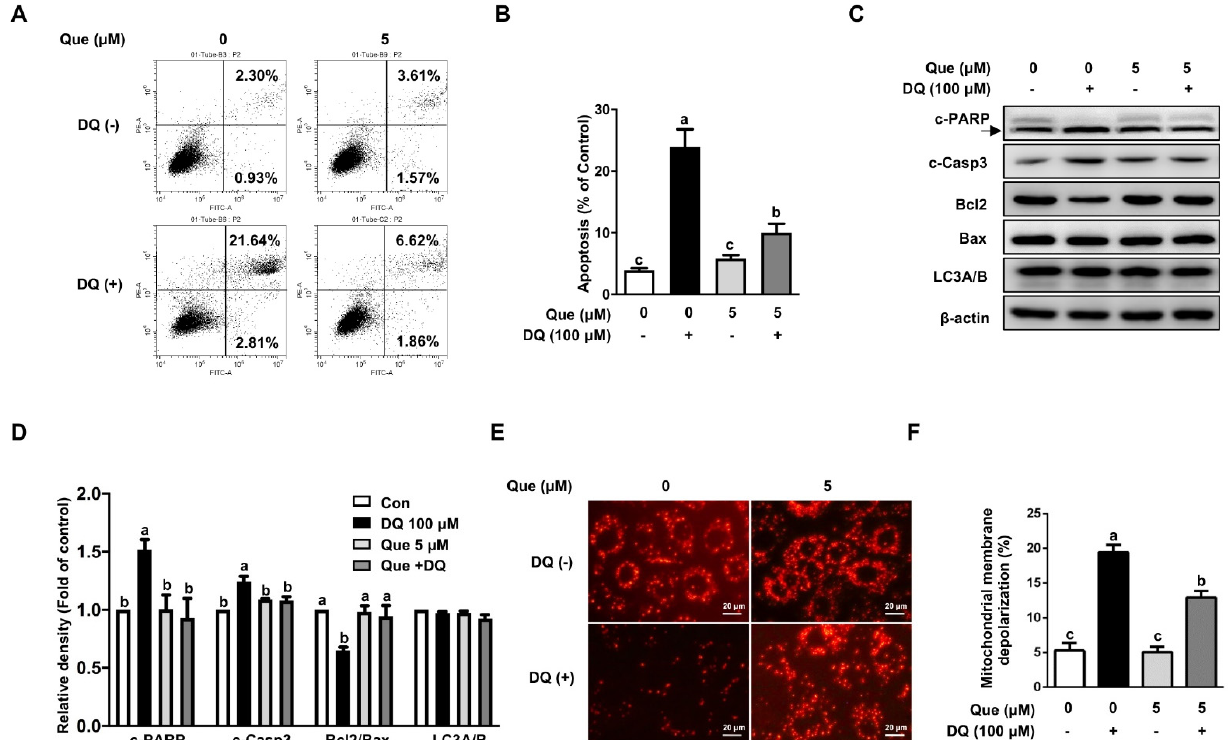
Figure 2. Quercetin attenuated diquat-induced apoptosis and mitochondrial membrane depolarization in IPEC-1 cells. IPEC-1 cells were pretreated with 5 µ M quercetin for 24 h and then challenged with 100 µ M diquat for 6 h. ( A , B ) Apoptosis were determined and analyzed by flow cytometry. ( C , D ) Protein abundances for c-PARP, c-Casp3, Bcl2, Bax, and LC3A/B were determined and quantified by Western blot assay. β -actin was used as the loading control. ( E ) Mitochondrial membrane potential was visualized by JC-1 staining in a fluorescence microscope (magnification × 400). ( F ) Mitochondrial membrane depolarization was analyzed by flow cytometry. Representative experimental results were repeated in three independent experiments and values are means ± SEMs, n = 3. Means without a common letter are considered as a significant difference, p < 0.05.